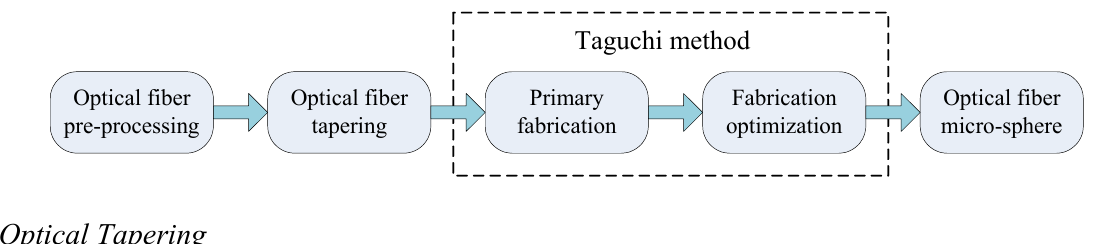
Figure 1. Fabrication process of an integrated optical fiber